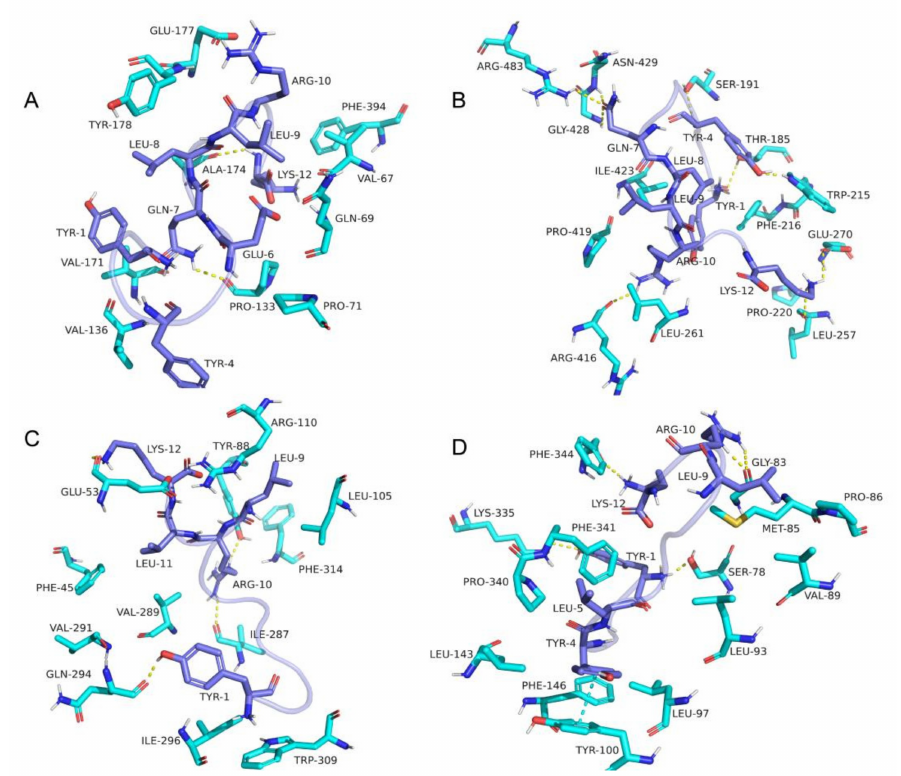
Figure 5. Molecular docking analysis of the binding mode of BCp12. ( A ) 3-ketoacyl COA thiolase (fadA, Alphafold database). ( B ) acyl-CoA dehydrogenase (fadE, PDB ID:3DJL). ( C ) s-(hydroxymethyl) glutathione dehydrogenase (frmA, Alphafold database). ( D ) acyltransferase (aas,PDB ID:6Q3A). The yellow dotted line indicates hydrogen bonding, and the cyan dotted line indicates pi-pi